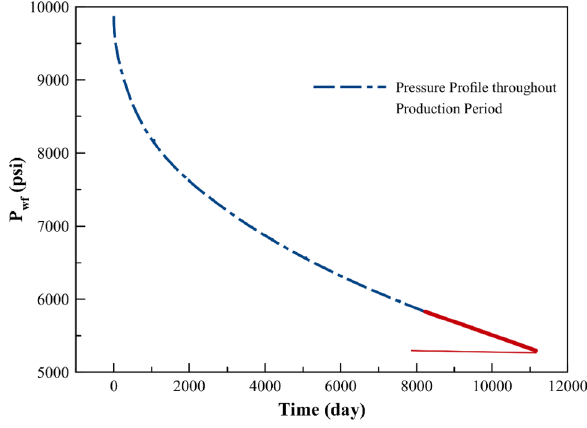
Fig. 8 Bottomhole pressure profile throughout production period